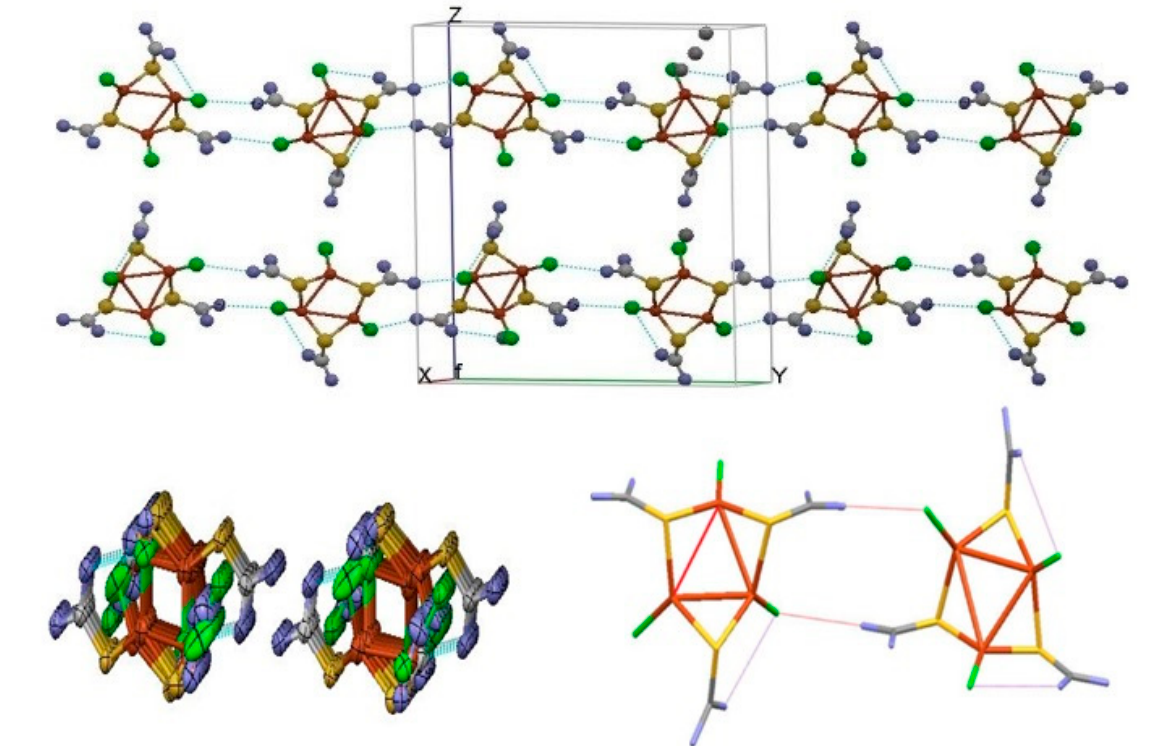
Figure 4. The molecular structure of compound 1 , only non-carbon atoms are numbered. Ellipsoids are drawn at 50% probability level; hydrogen atoms are omitted and carbons are represented by capped sticks.